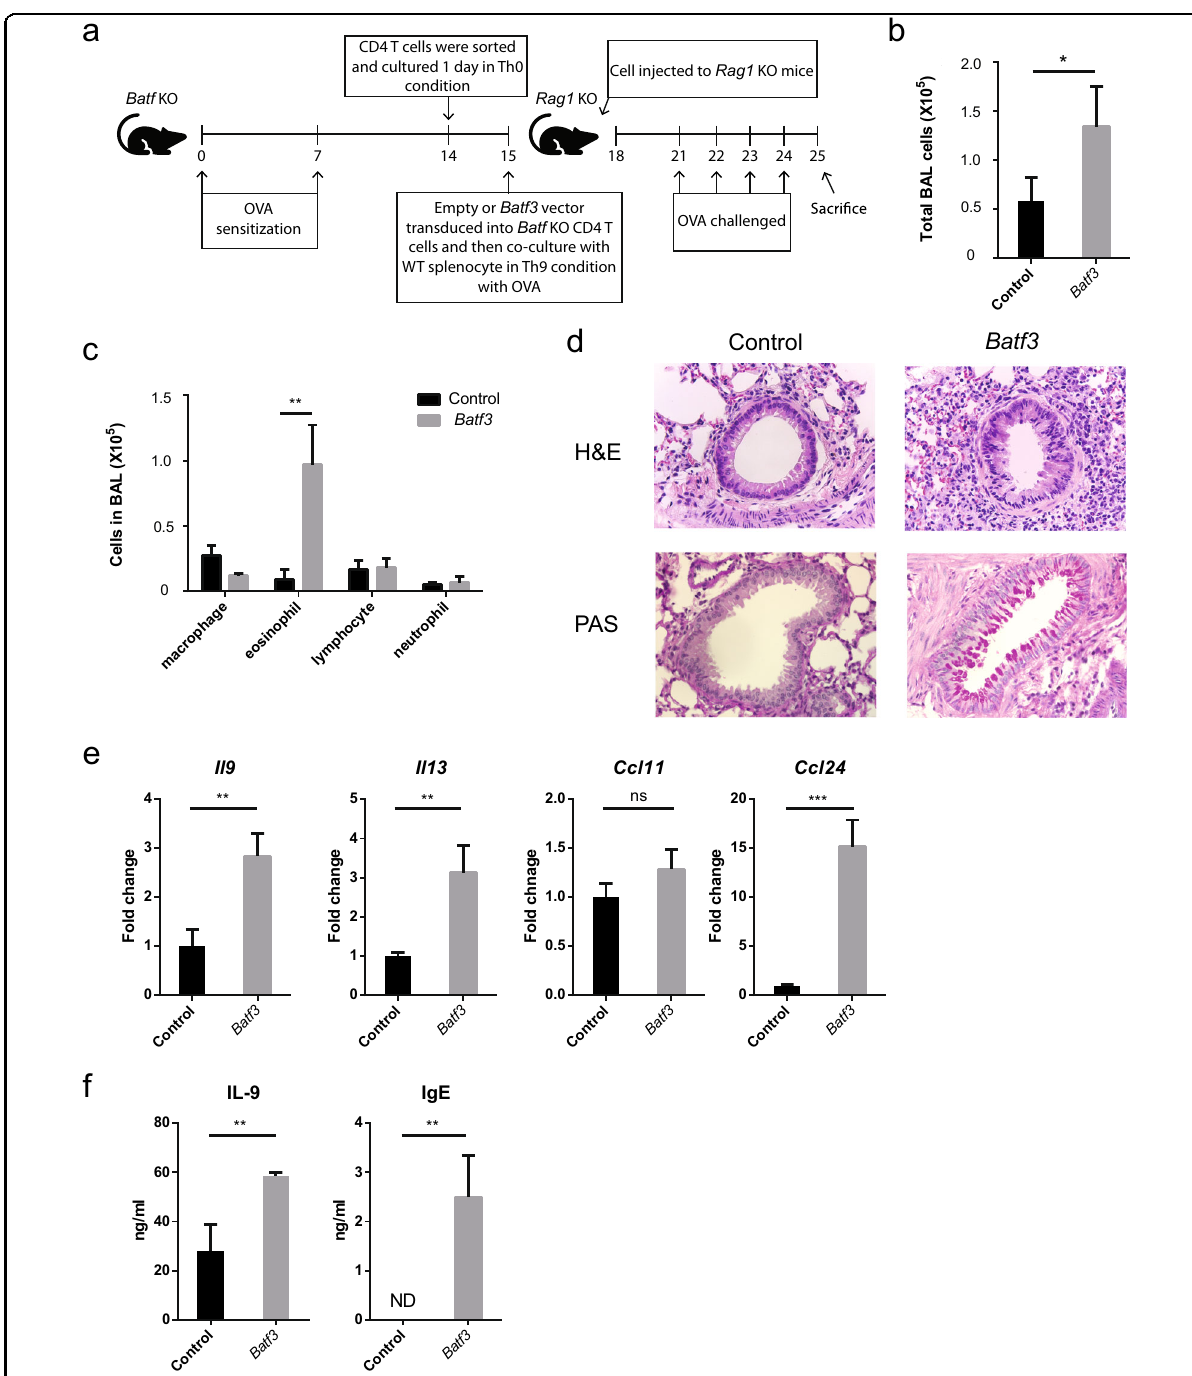
Fig. 6 Batf KO Th9 cells induce airway in fl ammation upon overexpression of Batf3 . a Schematic diagram of the adoptive transfer model used to induce airway in fl ammation. Naive CD4 + T cells from OVA-sensitized Batf KO mice were isolated and cocultured with WT APCs under Th9 conditions in the presence of OVA. Next, the cells were adoptively transferred (intraperitoneally) into Rag1 KO mice. Recipient mice were challenged with an OVA aerosol. b The total number of BAL cells in the lungs of the mice was counted using a hemocytometer. c Cells were stained with Diff Quik to identify different cell types. Next, at least 150 cells were counted per sample. d Lung tissues were stained with H&E and PAS before histological analysis. The top panels show cells in fi ltrating the lung. The bottom panels show mucus production. e Expression of mRNA encoding asthma-associated genes was measured by qRT-PCR. Data were normalized to levels of Gapdh and are shown relative to control cells. f Secretion of IL-9 protein into BAL fl uid and IgE levels in mouse serum were measured by ELISA. Error bars represent the s.d. P values were calculated using Student ’ s t -tests. * P < 0.05, ** P < 0.01, and *** P < 0.001. All experiments were repeated independently three